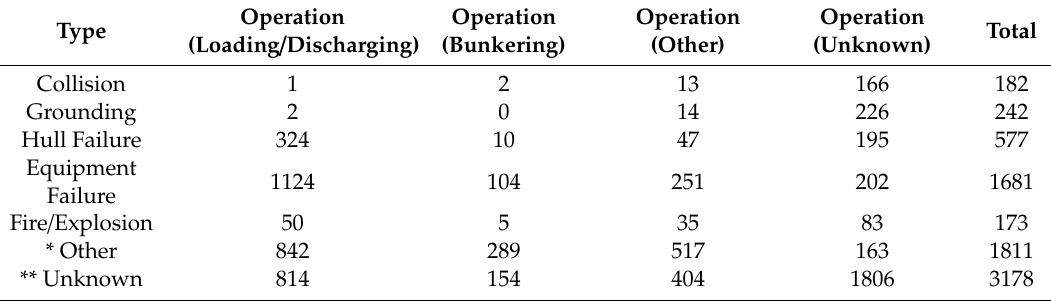
Table A1. Results of oil spill less than 7 tons from 1974 to 2012.